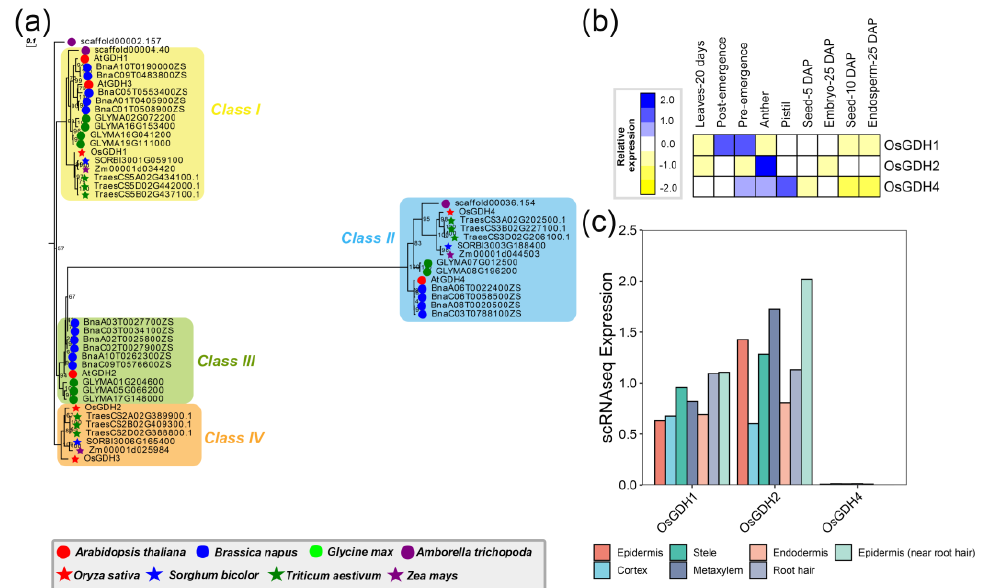
Figure 3. The phylogenetic analysis and expression pattern of the GDH superfamily. ( a ) represents the phylogenetic trees of the GDH superfamily. ( b ) indicates the expression heatmap of the GDH superfamily, and ( c ) represents the expression of the GDH superfamily through the single-cell transcriptome data of roots in rice.